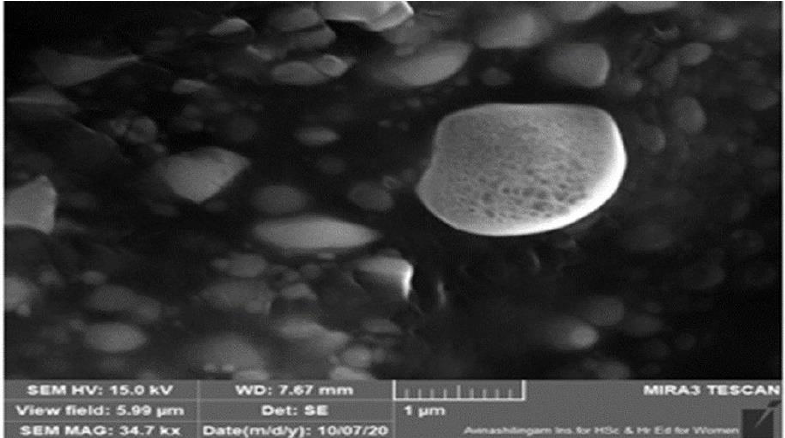
Figure 6. SEM vesicular image of optimized transferosome-loaded proanthocyanidin.